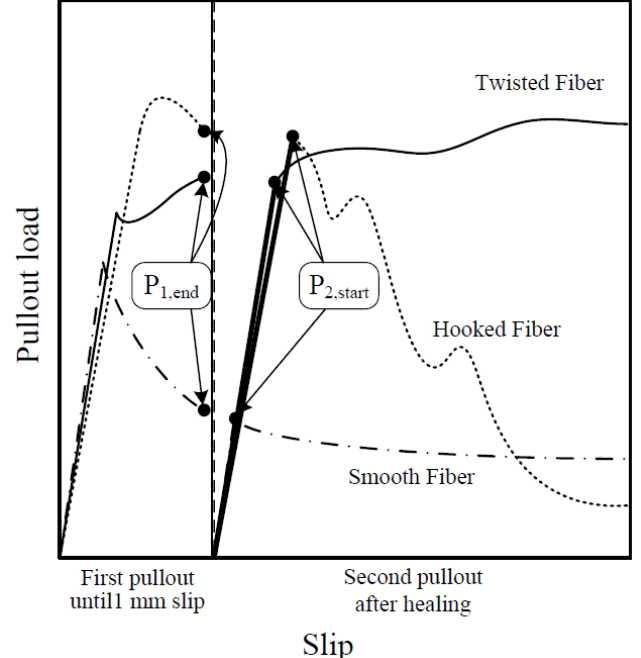
and P according to types of fiber and healing condition. 1,max 2,max